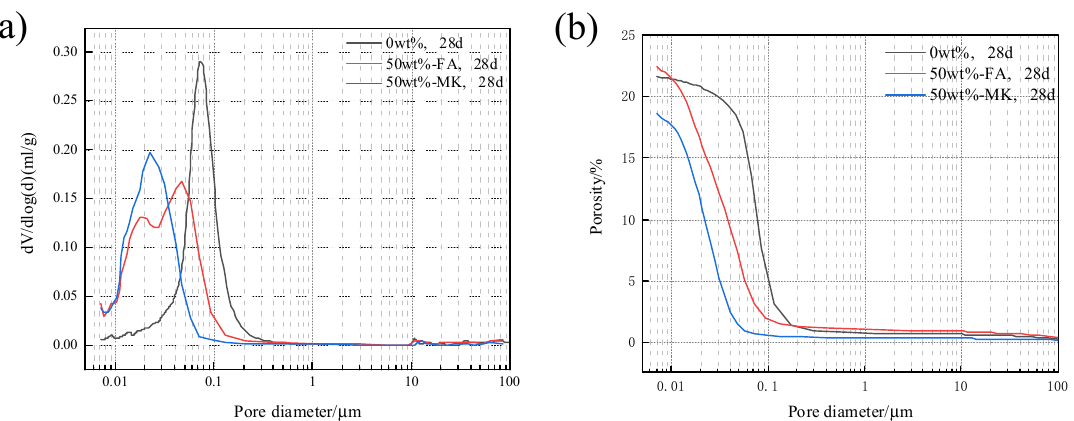
Figure 9. Pore structure of samples cured in 1 M NaOH at 80 ◦ C for 28 days: ( a ) pore size distribution, ( b ) cumulative